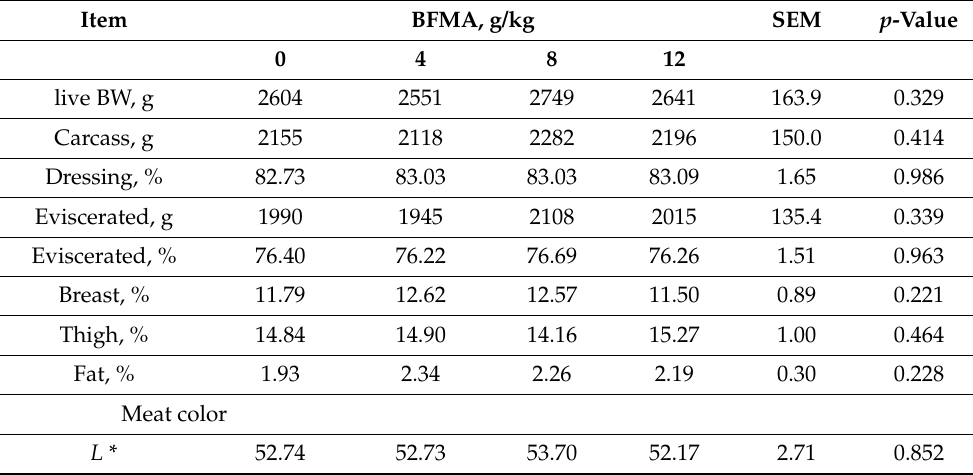
Table 3. Effects of dietary malic acid on the carcass traits and meat quality of broilers.